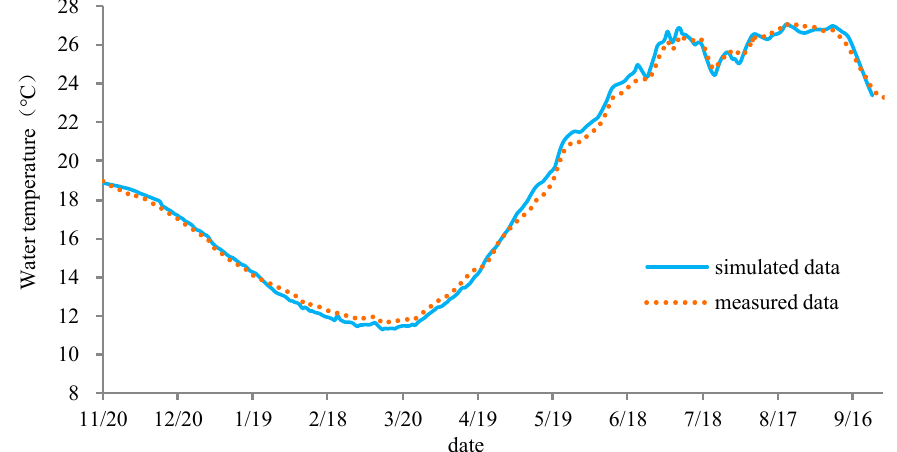
Figure 4. Comparison of the simulated and measured temperatures of water discharged from the TGD (from 20 November 2012 to 9 December 2013).